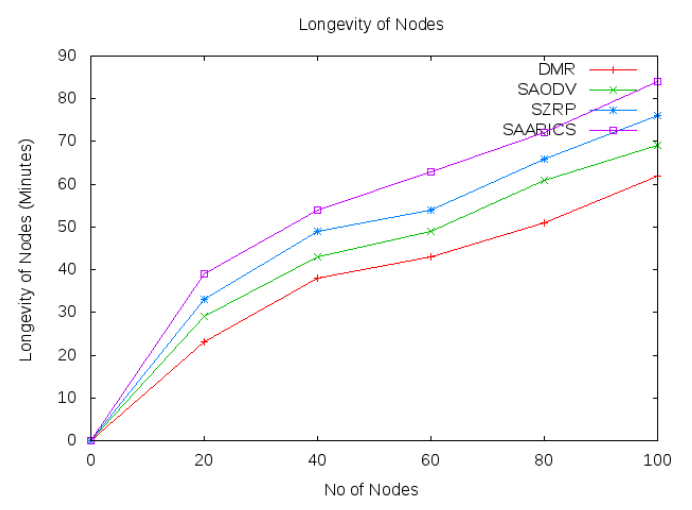
Figure 7. Longevity of Nodes.